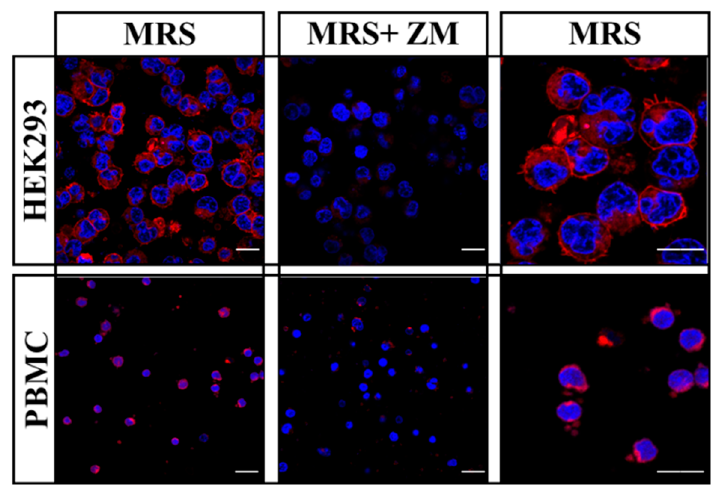
Figure 3. A 2A R detection in living cells using a fluorescent ligand. HEK-293 cells permanently expressing A 2A R and human peripheral blood mononuclear cells (PBMC) were incubated with 50 nM MRS7396 (MRS, red) in the absence or presence of 100 nM of ZM241385 (ZM). For live nuclear staining cells were incubated with 1 μ M Hoechst 33342 (blue). Scale bar: 20 μ m.